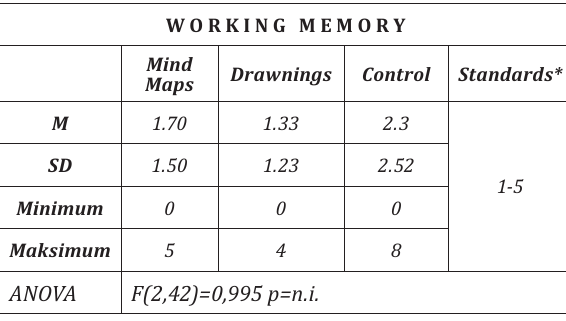
Table 1. Presentation of average results for the working